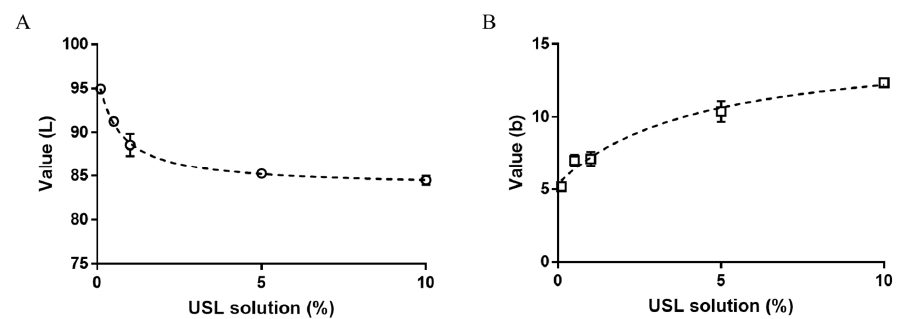
Figure 2. Pigmentation evaluation by measuring the color change on the egg shell membrane according to USL solution concentration (%): ( A ) L* value, ( B ) b* value. The R 2 values were 0.9778 and 0.9631 for A and B, respectively ( n = 3).